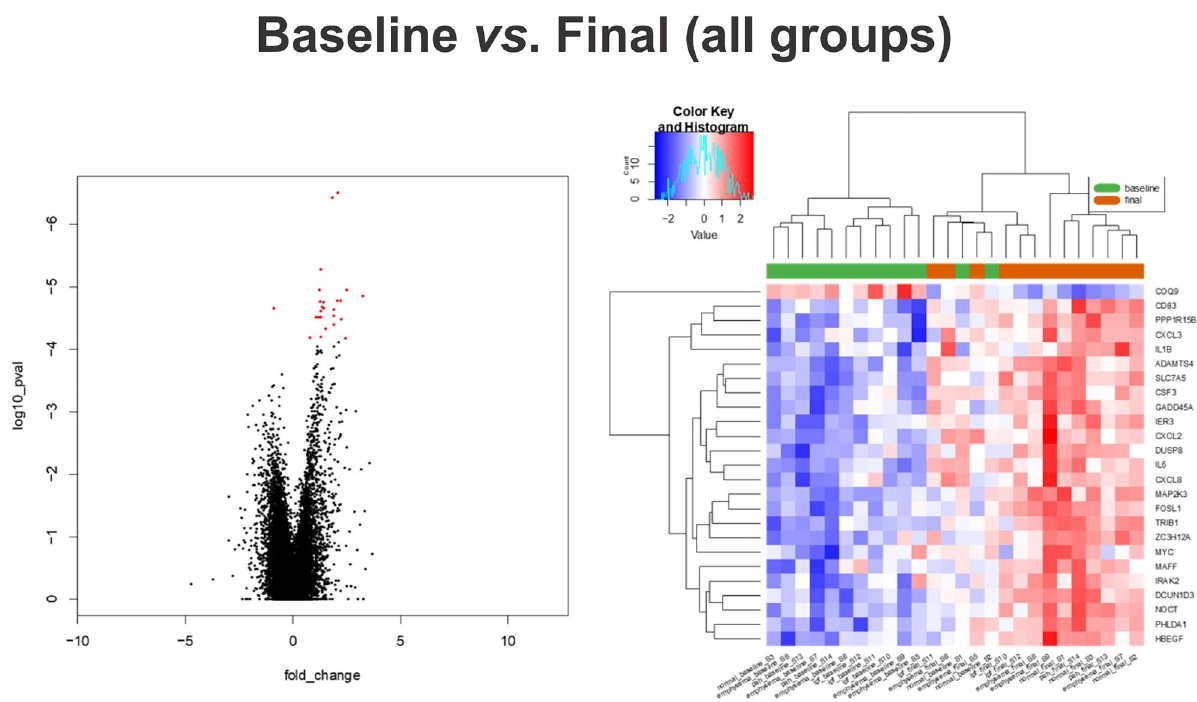
Figure 5. Heatmap and volcano plot of differentially expressed genes before and after EVLP of all lung samples. FDR adjusted p value < 0.05.